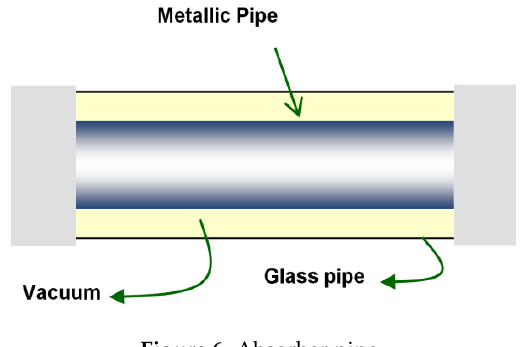
Figure 6. Absorber pipe.